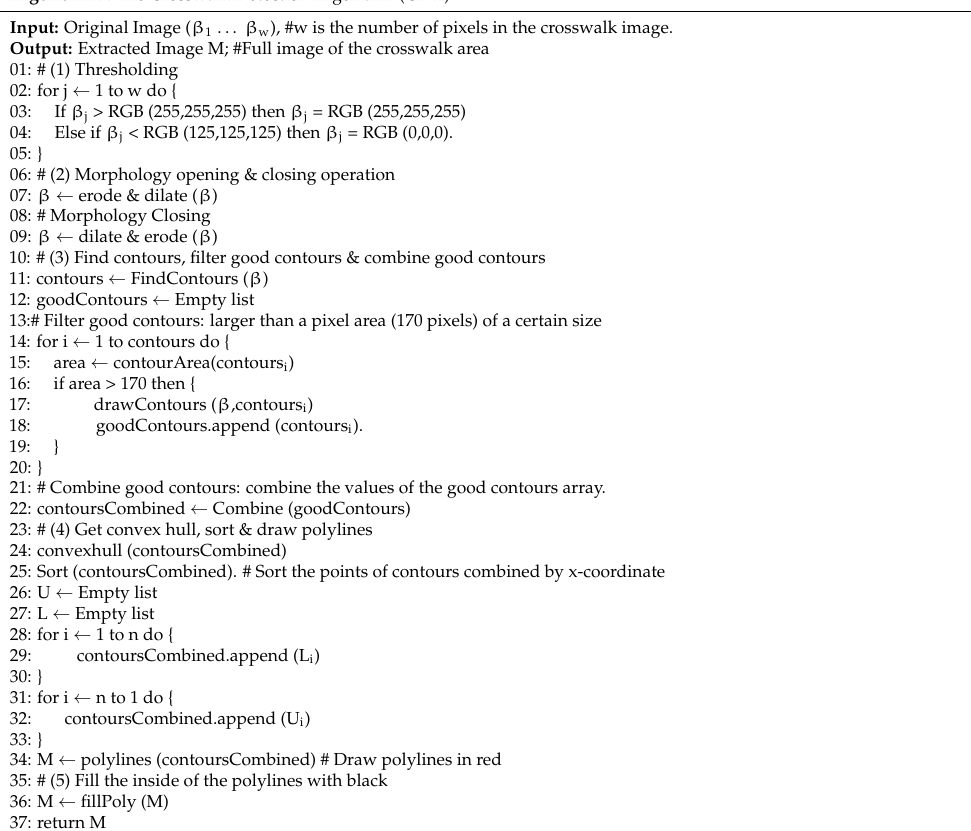
Algorithm 1: The Crosswalk Detection Algorithm